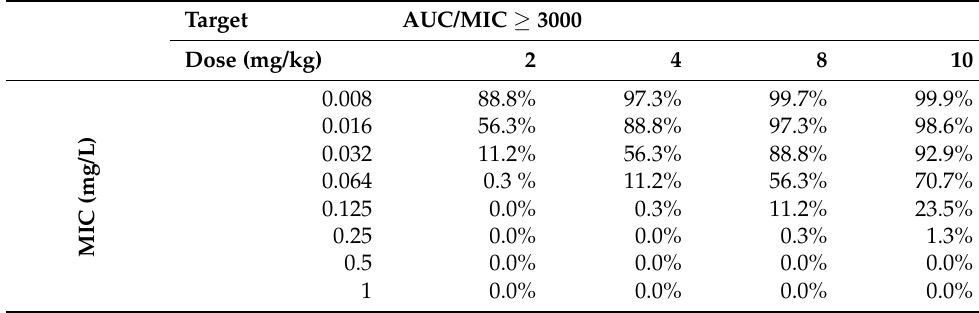
Table 6. Microbiological success according to the different doses of micafungin, the identified minimum inhibitory concentration (MIC), and the AUC/MIC ratio.